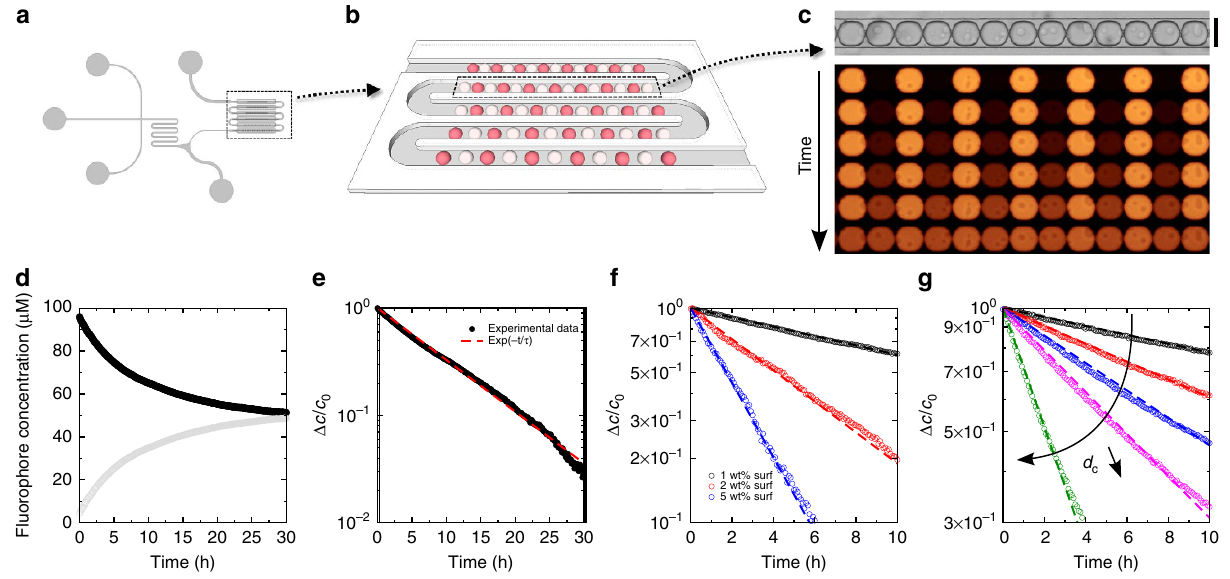
Figure 3 | Fabrication and control of minimal emulsions. ( a ) Sketch of the device for droplet production and storage as alternating row (see Supplementary Fig. 1 and Supplementary Note 1). ( b ) On one single chip, several packing distance are tested under the same condition. ( c ) White-light micrograph of an immobilized row of droplets (scale bar, 100 m m) and time evolution of one row of droplets (0, 1.5, 3, 6, 12 and 24h after immobilization, for a surfactant concentration C ¼ 1wt% and a distance d c ¼ 4 m m.) in fluorescence. ( d ) Relaxation to equilibrium of the average fluorophore concentrations of initially filled (filled circles) and empty droplets (empty circles) ( e ) The concentration difference between the two droplet populations decays exponentially. ( f ) Variation of the kinetics as a function of surfactant (surf) concentration (for d c ¼ 15 m m). ( g ) Relaxation dynamics of five one-dimensional droplet microarrays for edge-to-edge distance d c (cid:2) 2 r between the droplets of 30 m m (black), 15 m m (red), 10 m m (blue), 4 m m (pink) and 1 m m (olive) (for C ¼ 1wt%).